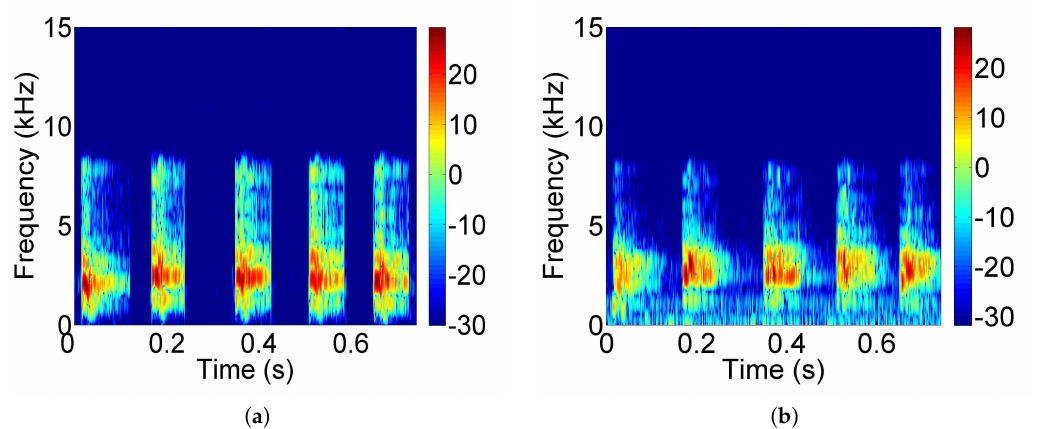
Figure 15. Comparison of the spectrogram of the call sample and the received signals; ( a ) The spectrogram of the dolphin calls sample; ( b ) The spectrogram of the received